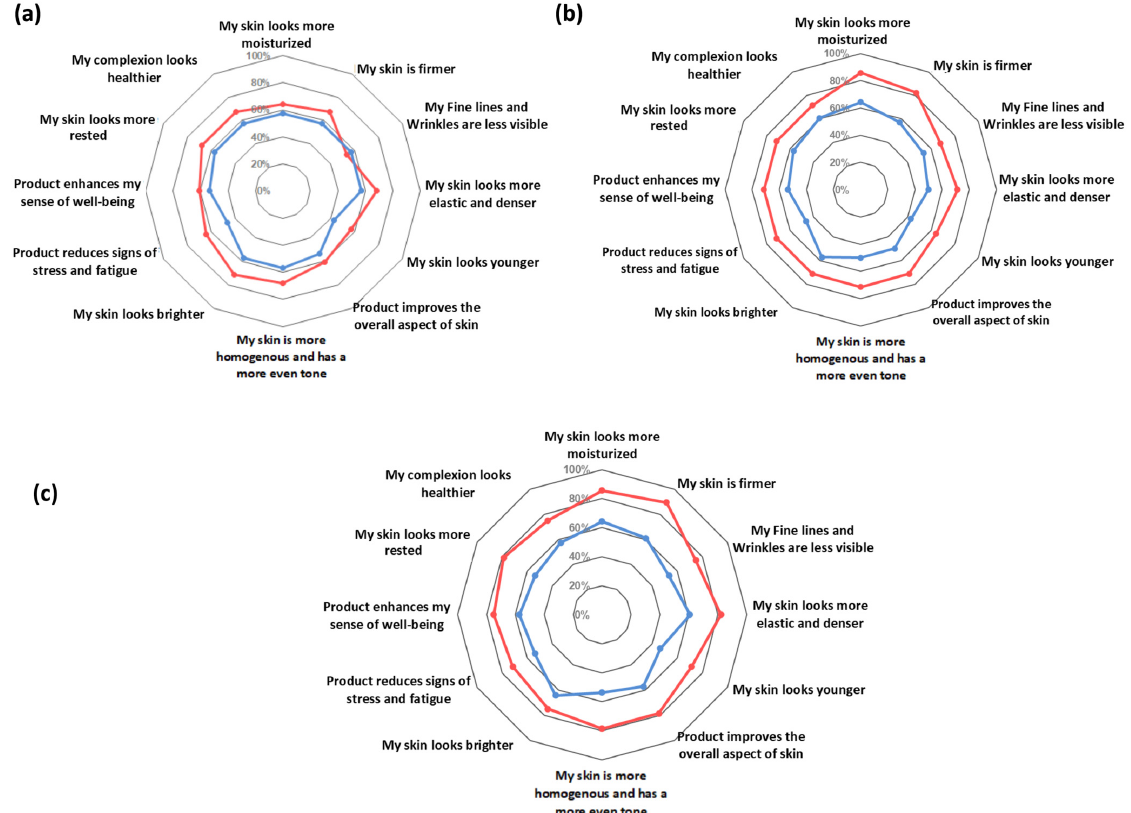
Figure 7. Self-assessment questionnaire results. ( a ) Self-assessment questionnaire output at D28. ( b ) Self-assessment questionnaire output at D56. ( c ) Self-assessment questionnaire output at D84. Active product EY (red line); placebo product (blue line).